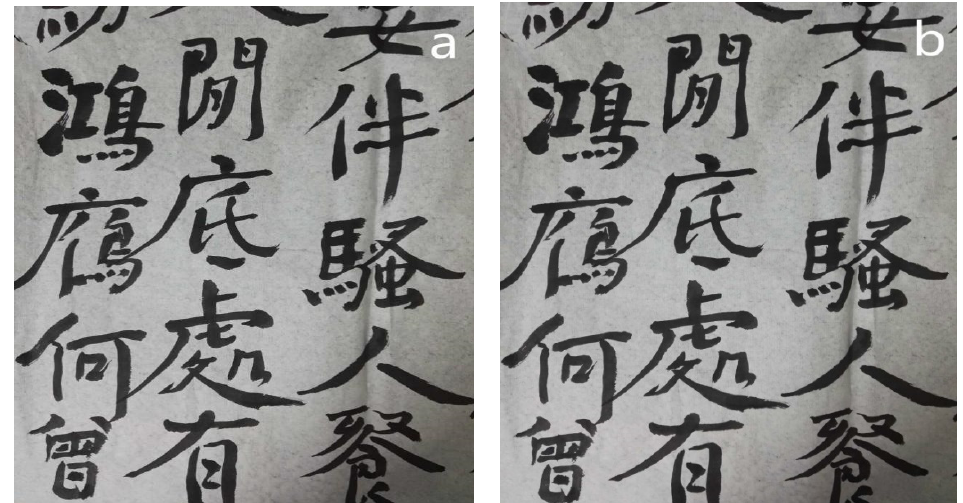
Figure 13. The appearance of the calligraphy work treated before ( a ) and after ( b ) with synthetic polyurethane.